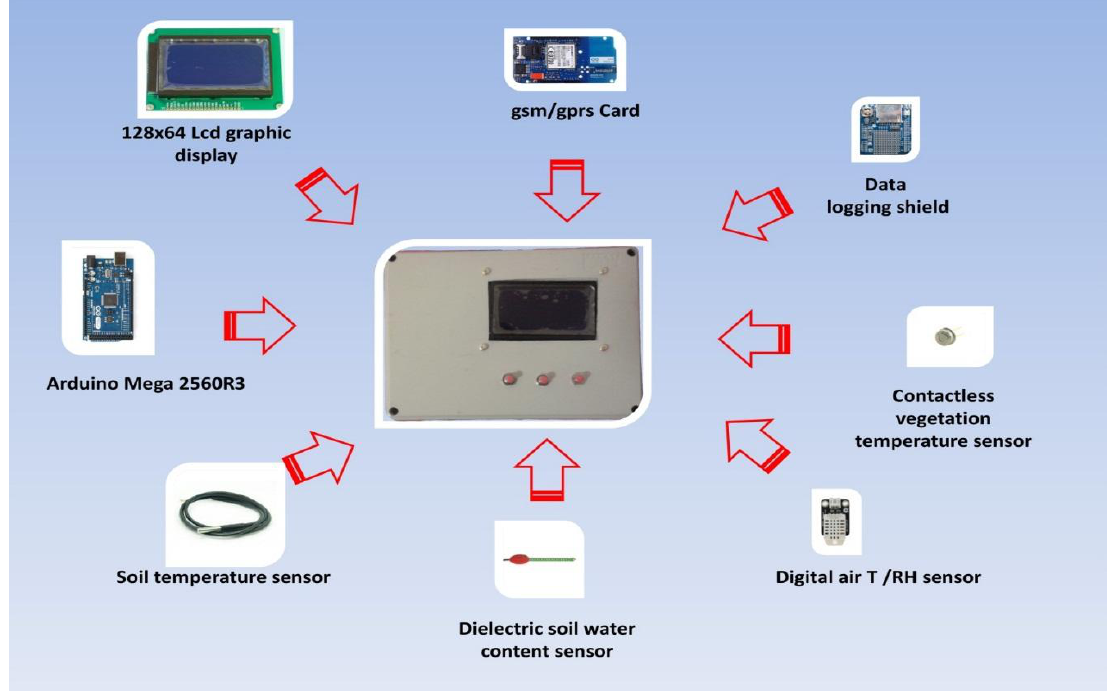
Figure 1. Components of platform.